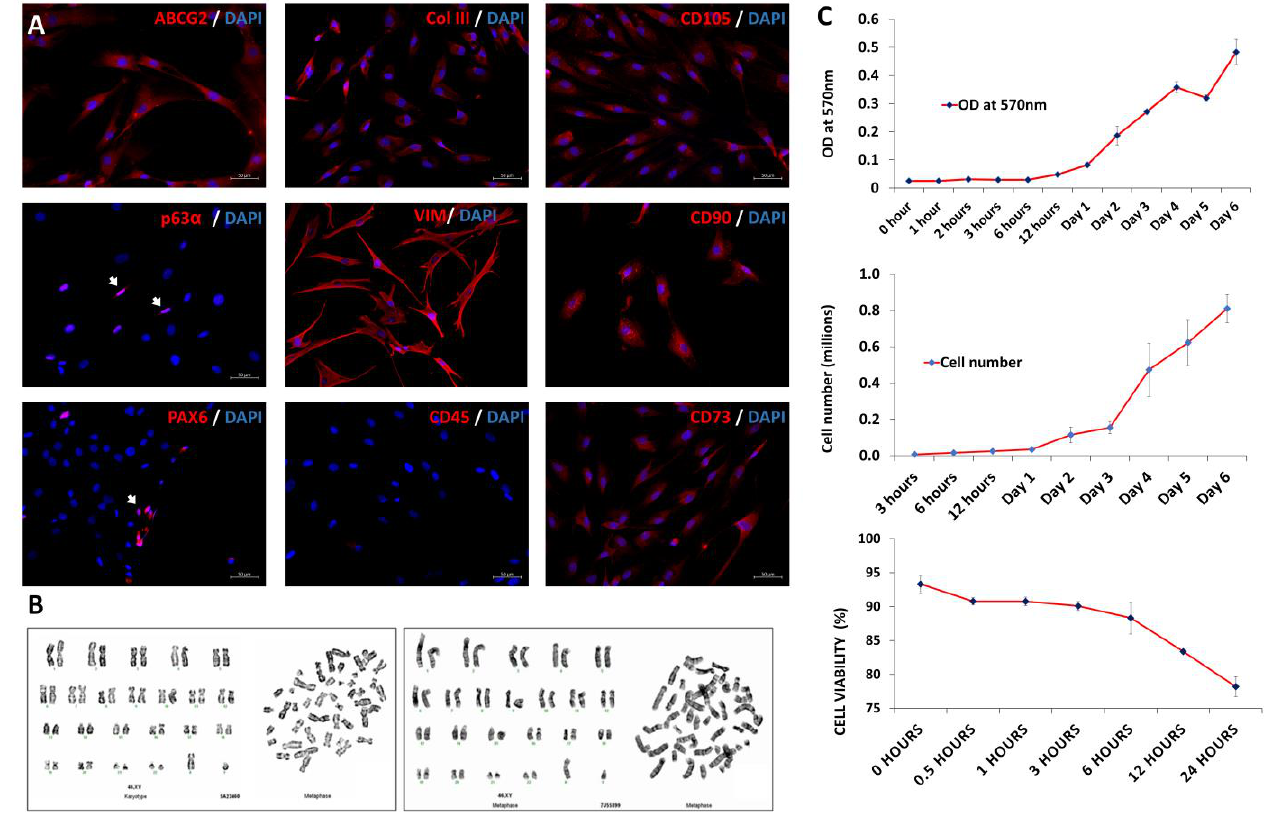
Figure 2. hLMSC phenotyping and stability. ( A ) Immunostaining assessment of the hLMSC phenotype before administering them to rabbit corneas. The panel shows stem-cell biomarkers (p63+, Pax6+, ABCG2+) and mesenchymal biomarkers (VIM+, CD45 − , CD73+, CD90+, and CD105+) stained red against DAPI, nuclear stain (blue). 40×; 50 μM. ( B ) Karyotyping of hLMSCs before and after encapsulation and transport (n = 3). Both groups showed no numerical or significant reforms. ( C ) Top graph shows the hLMSC growth in culture. Third-passage cells were seeded in equal numbers into well plates and assessed via the MTT assay for 7 days (n = 3). The 570 nm absorbance was plotted against culture duration. The dye-exclusion graph of the hLMSC culture growth (middle). The bottom graph shows the viable cell percentage in pellet at various time points when stored at 2 – 8 °C. The hLMSCs were stable with 90.09 ± 0.06 percent viability at 3 h and 88.33 ± 2.37 percent viability at 6 h (n = 3), the timeframe for corneal transplantation.